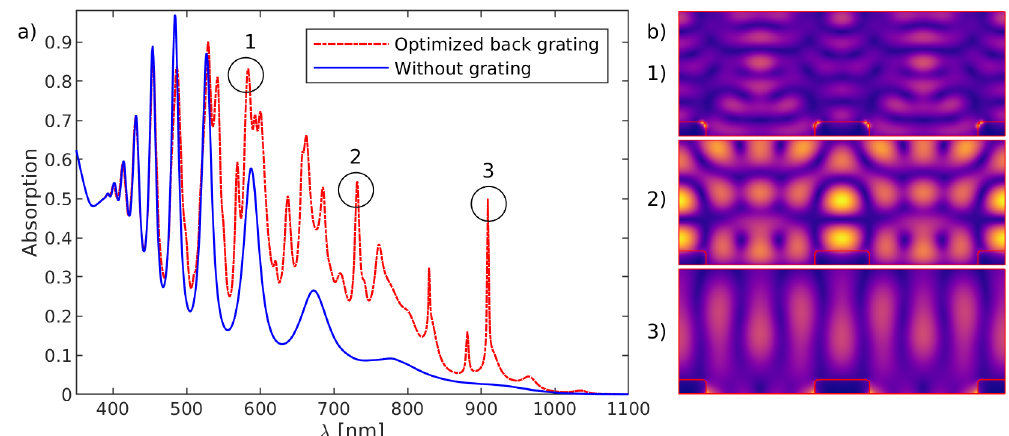
Figure 2. ( a ) simulated spectral response of the active layer’s optical absorption in structures without periodic back grating (solid blue line) and with optimized periodic back grating (red dash-dotted line); ( b ) simulated electric field distributions at the operating wavelengths as labelled in the graph ( a